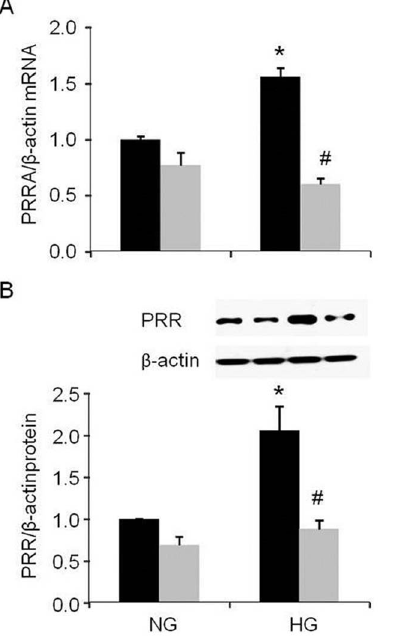
Figure 5. Effect of PRR siRNA on PRR expression in podocyte upon high glucose. A. Real time PCR analysis of PRR mRNA expression (n=6); B. Western blot analysis of PRR protein expression (n=5–6); PRR, (Pro)renin receptor; Normal glucose, 5 mM D-glucose (NG); high glucose, 25 mM D-glucose (HG). Black bar, Scrambled siRNA; Grey bar, PRR siRNA. Data presented as mean 6 SEM, * p , 0.05 vs NG + Scrambled siRNA; # p , 0.05 vs HG + Scrambled siRNA.